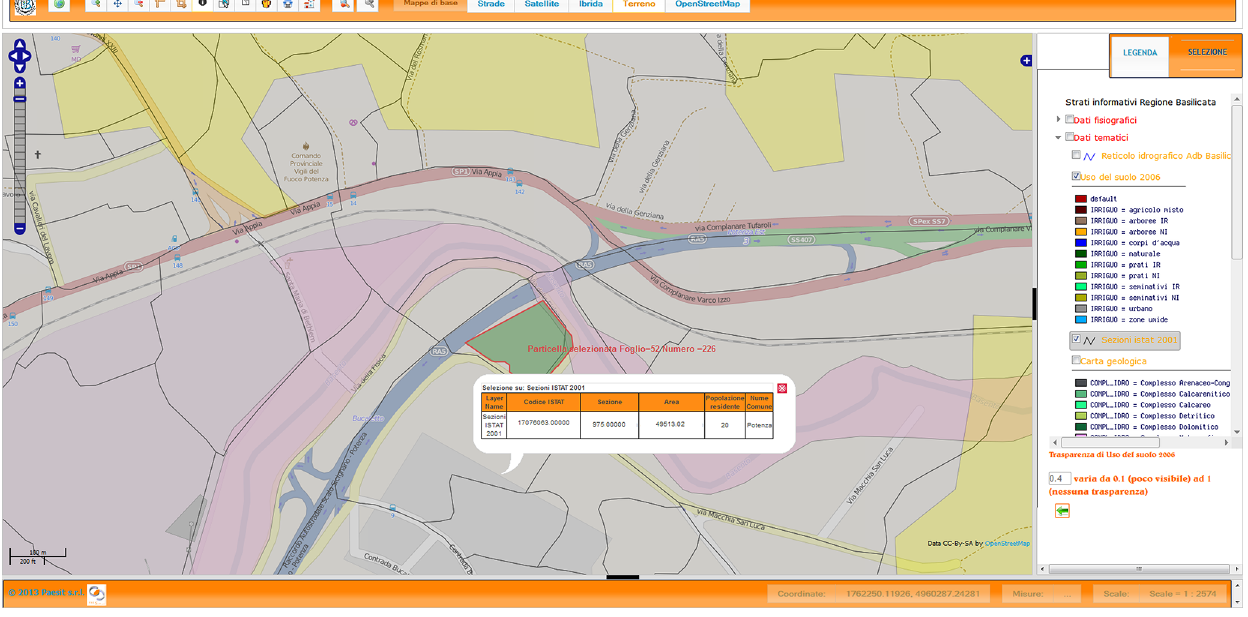
Figure 6. Example of a flood hazard map for a municipality within the Basilicata region, created by a user of READY. This hazard map is overlayed on the land use map, OpenStreetMap background map and census area map. The pop-up, in the centre of the figure, represents a query about the resident population in a selected census area.